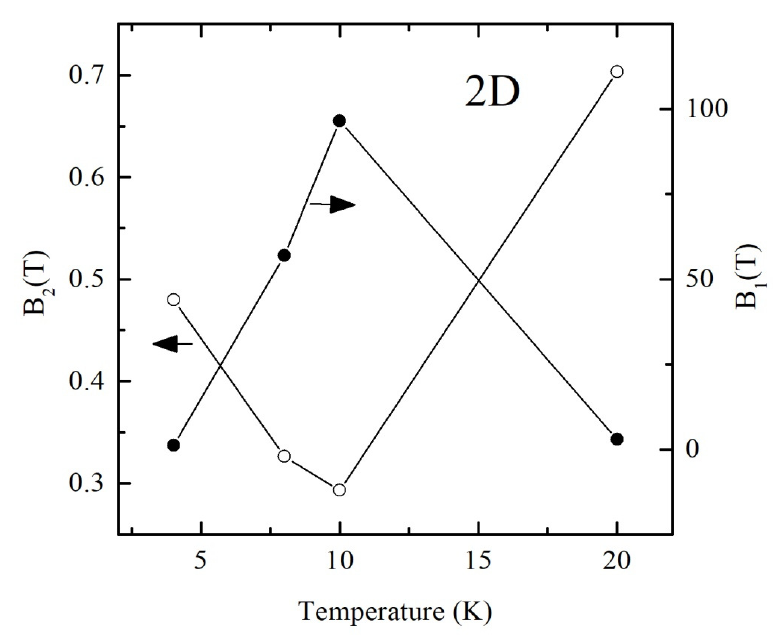
Figure 7. Temperature dependences of the parameters B 1 and B 2 calculated from the fitting curves using Formula (6) for polycrystalline SnO 2 − δ (sample B).